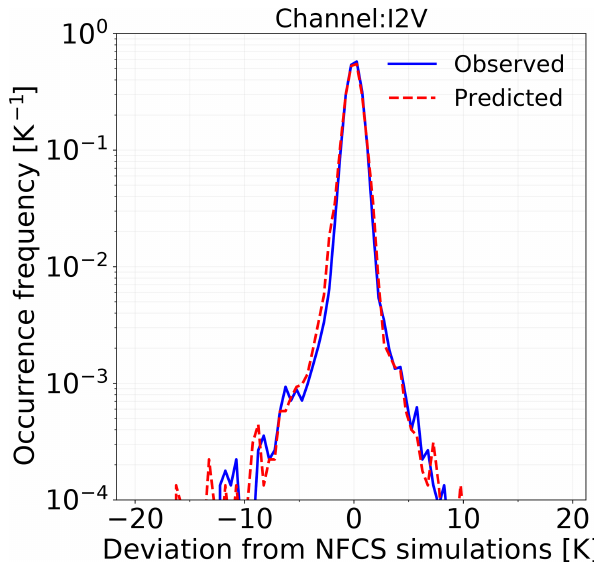
Figure 12. Same as Fig. 8 but from QRNN-single for ICI channel I2V.